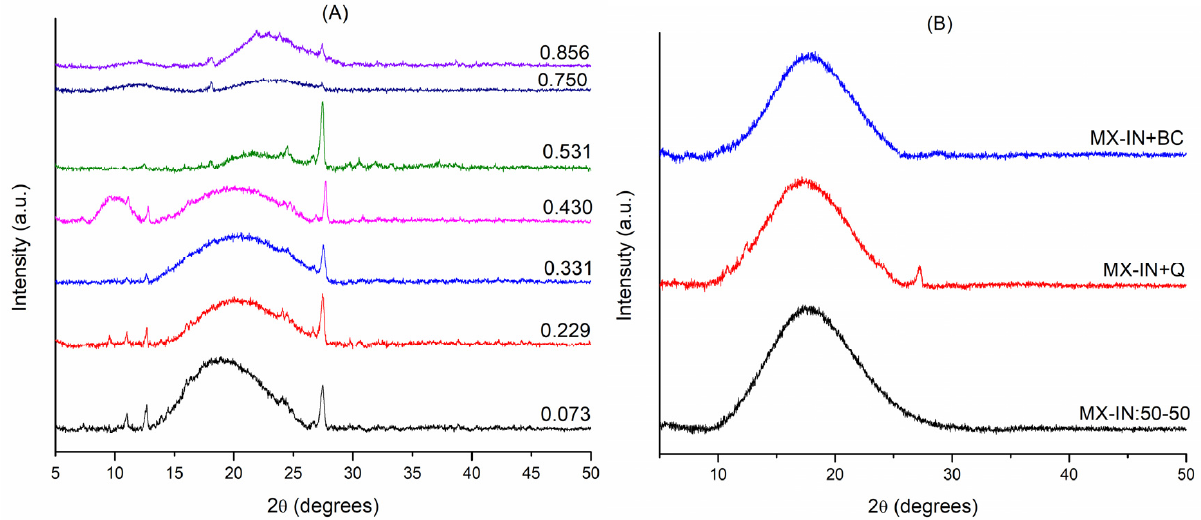
Figure 3. XRD diffractograms: ( A ) functional food blend MX-IN:25-75 at the different a w ; and ( B ) blank samples.